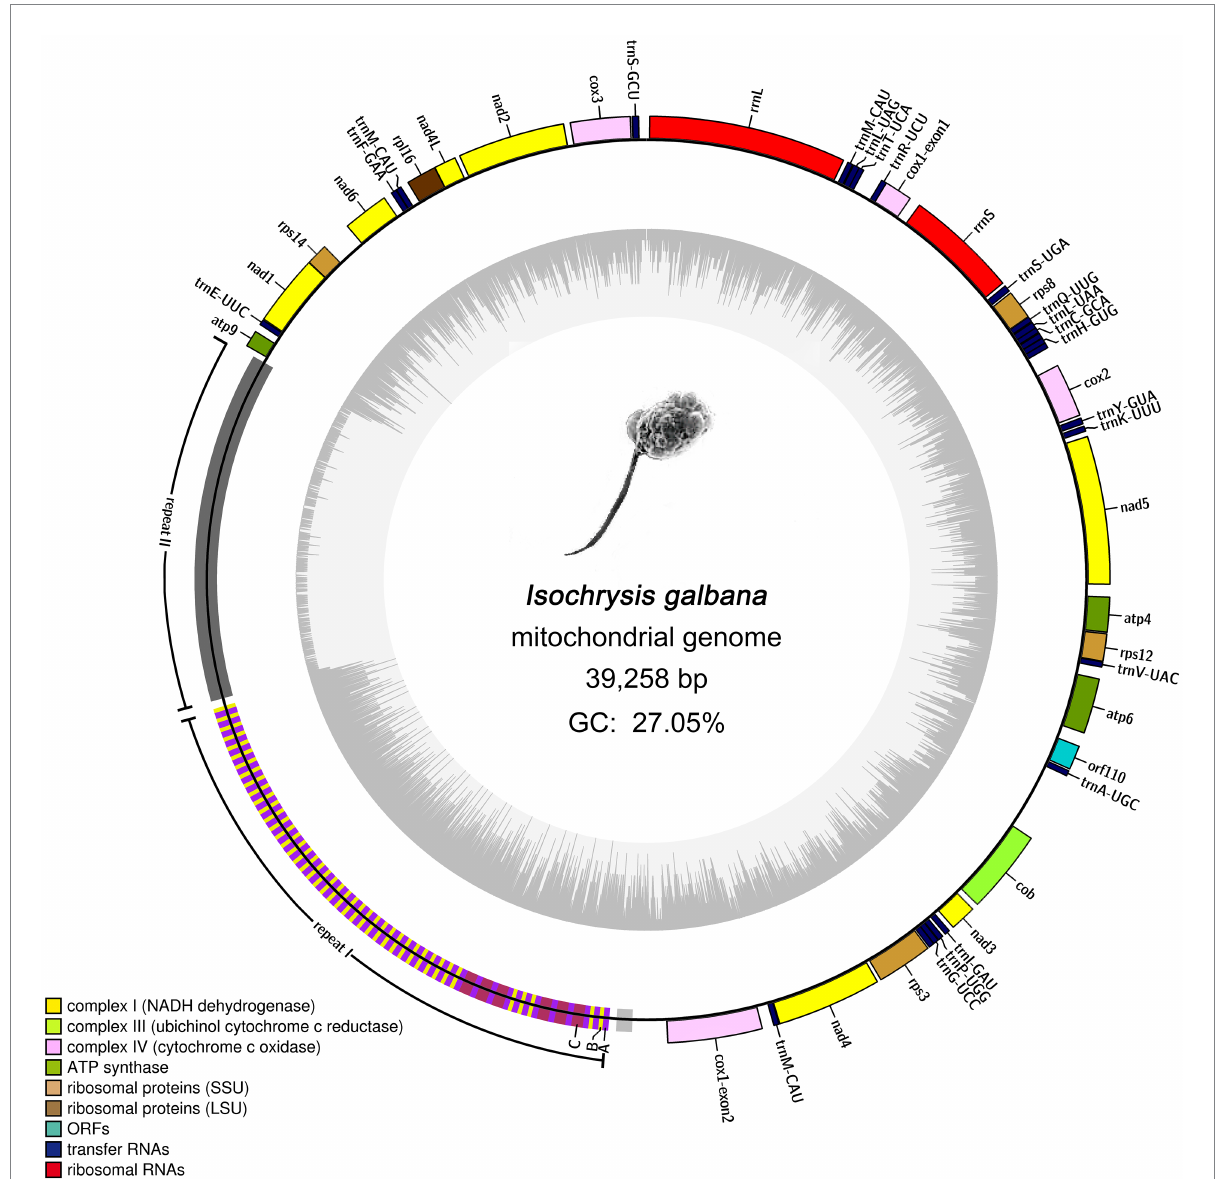
FIGURE 1 Mitochondrial genome map of Isochrysis galbana (Isochrysidaceae). Genes facing outside of the circle are transcribed in the clockwise directions. All genes are transcribed in the same direction. Genes are colored according to different functional groups. A split ribosomal operon is present, comprising genes encoding small ( rrnS ) and large ( rrnL ) subunits of rRNAs; No 5S rRNA gene was detected. The large block of repeat region (12.7 kb) represents a significant portion (~32.24%) of the entire genome. Detailed representation of the large complex repeat region is shown. The whole repeat region could be arbitrarily divided into two large tandem repeats (repeat I and repeat II) and one small flanked tandem repeat. Repeat I was composed of three subunits designated A, B, and C. Blocks A, B, and C have rarely perfect sequence